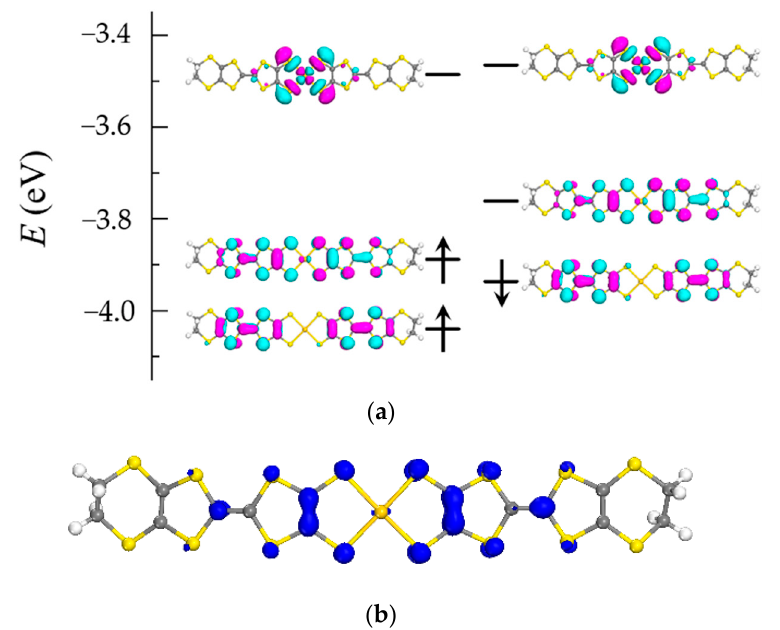
Figure 5. ( a ) Spin polarized molecular orbitals and the energy levels of the neutral [Au(etdt) 2 ] molecule. ( b ) Spin density distributions of the neutral [Au(etdt) 2 ]